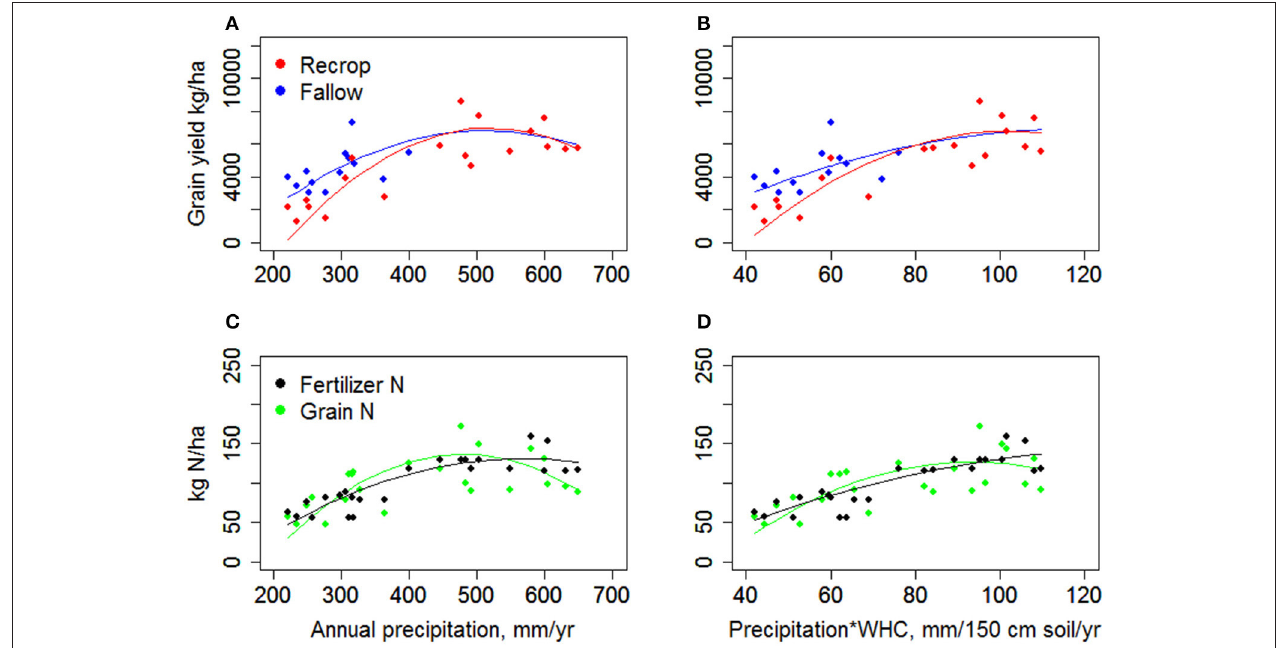
FIGURE 2 | Influence of annual precipitation on (A) winter wheat yields following crops or with fallow when annual precipitation < 350 mm, (B) winter wheat yields following crops or fallow after adjusting annual precipitation for available soil water holding capacity, (C) winter wheat grain N accumulation and fertilizer N applications with increasing annual precipitation, and (D) winter wheat grain N accumulation and fertilizer N applications with adjusted annual precipitation based on the available water holding capacity.